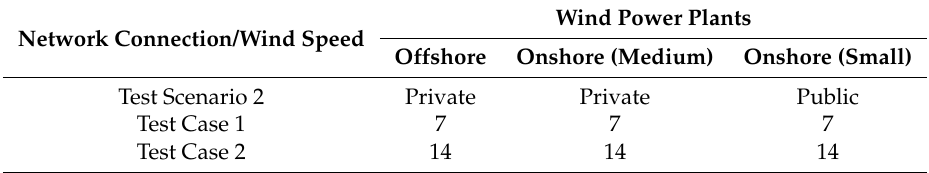
Table 7. Test Scenario 2—with Public Network Connection for Small Onshore